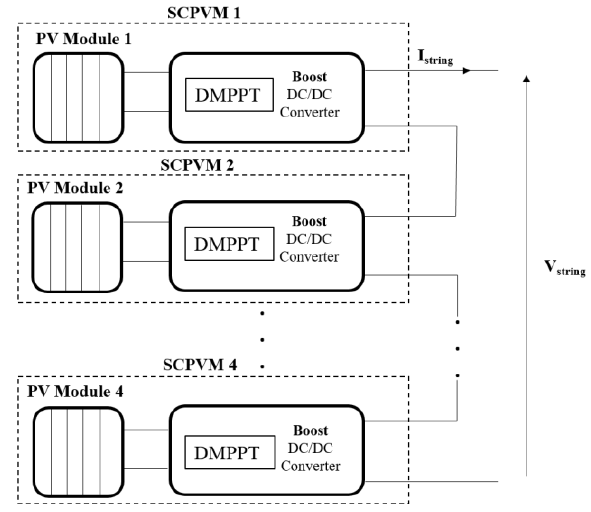
Figure 5. System under test.